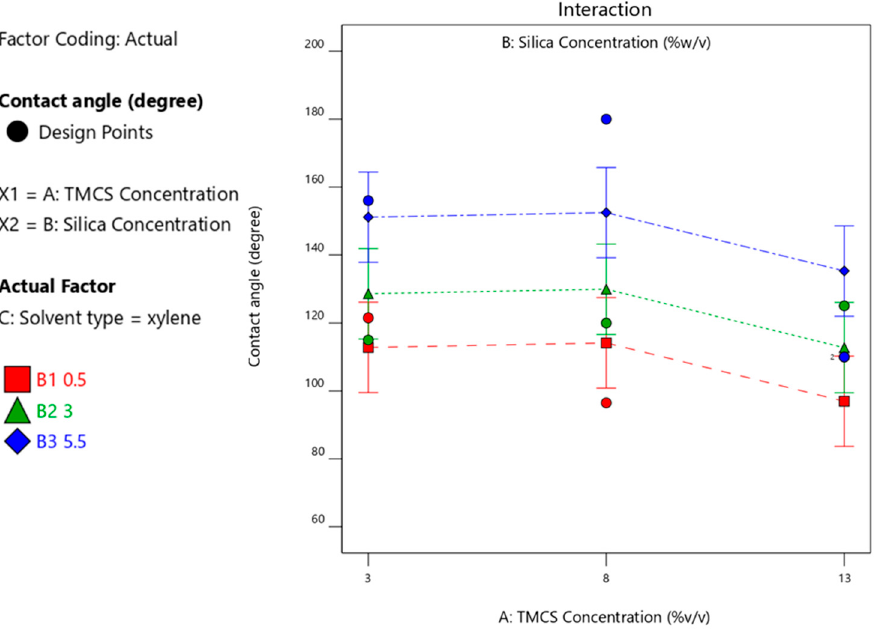
Figure 14. Contact angle upon interaction between TMCS and silica concentration with xylene solvent.